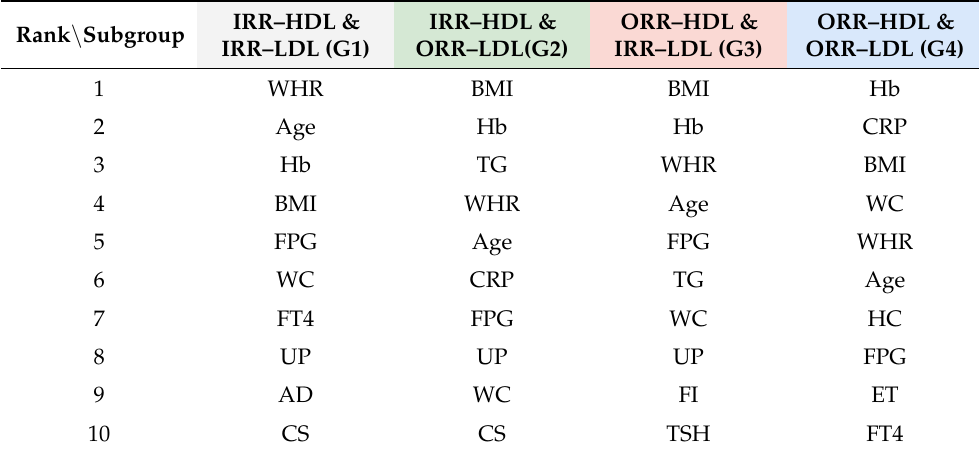
Table 5. Ranking of the top ten most important variables of the four subgroups. Rank \